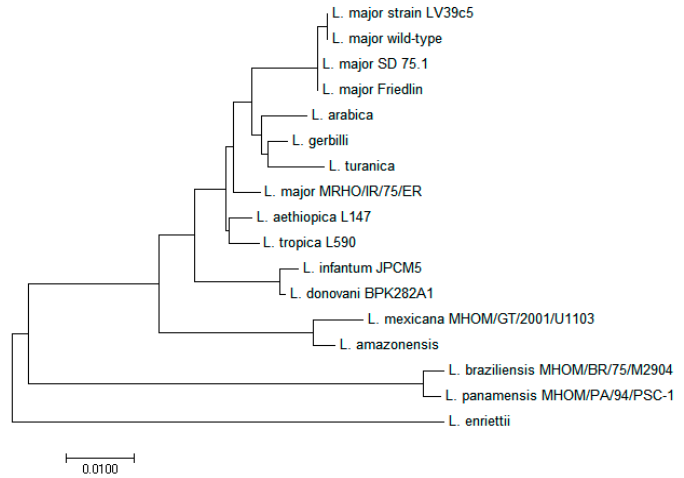
Figure 3. Phylogenetic analysis of CYP51 in different Leishmania species. Wild-type L. major in Iran is related to L. major strain LV39c5 in respect to CYP51 gene.